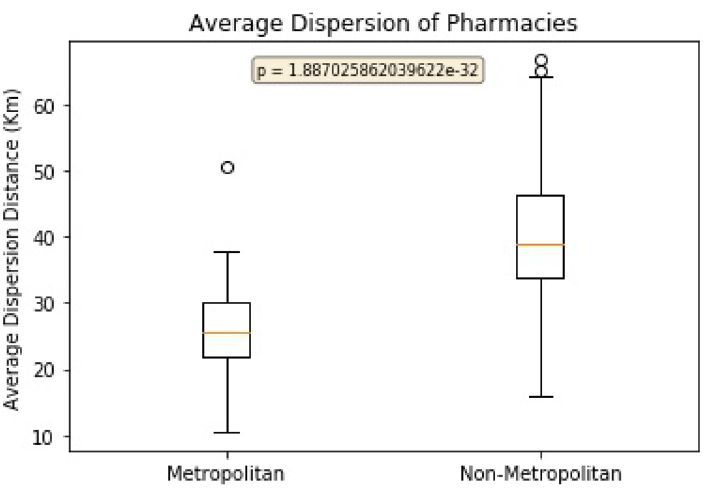
Figure 5. Dispersion of